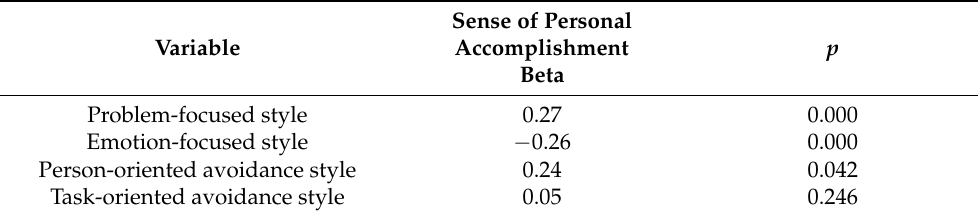
Table 5. Multiple regression model, the three coping styles as predictors to the explained variable of the sense of personal accomplishment.